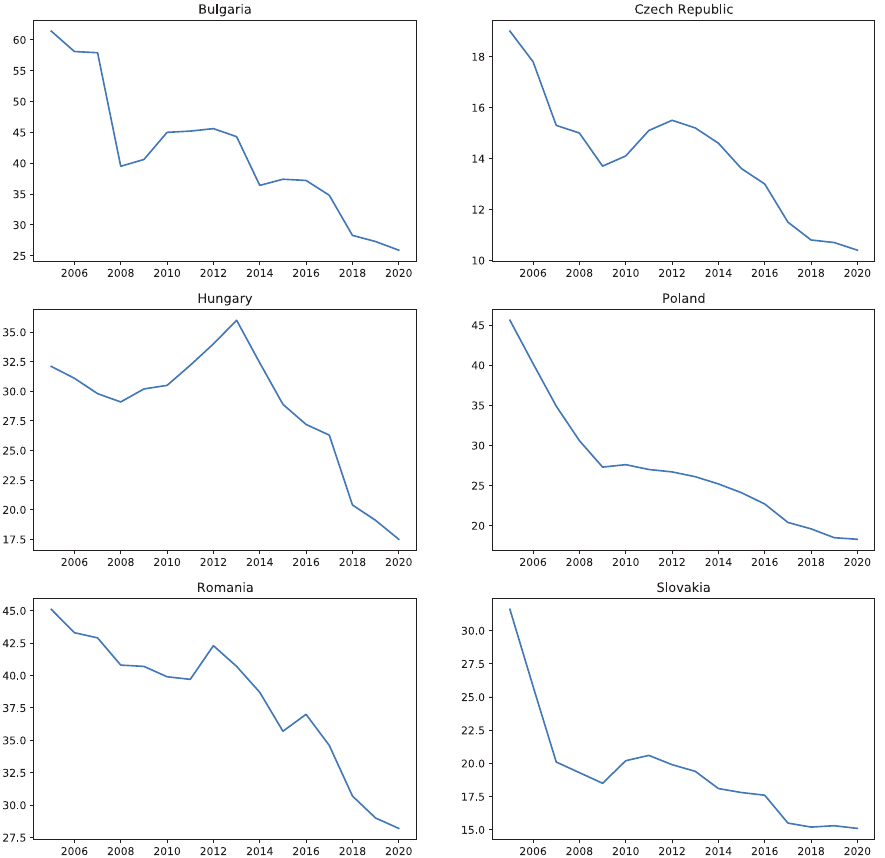
Figure 1. People at risk of poverty or social exclusion